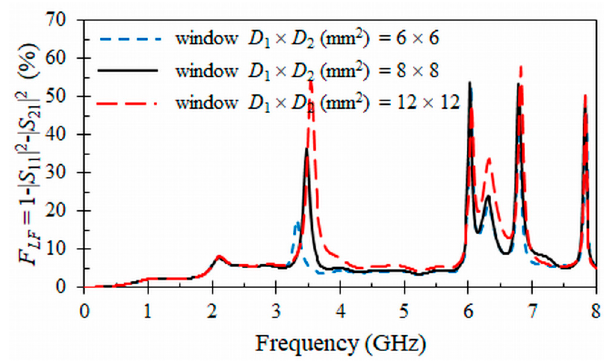
Figure 5. Forward loss factors (in %) for the proposed HMISW band-stop filter as a function of frequency and different open windows D 1 × D 2 . Dimensions (mm) and permittivity: r = 1.9, c = 0.3, g = 0.2, W HMSIW = 11.65, s = 1.2, d = 0.6, W m = 0.594, W t = 4.66, L 1 = 5, L 2 = 11, L t = 28.95, h = 0.635, and ε r = 10.2 (tg δ = 0).